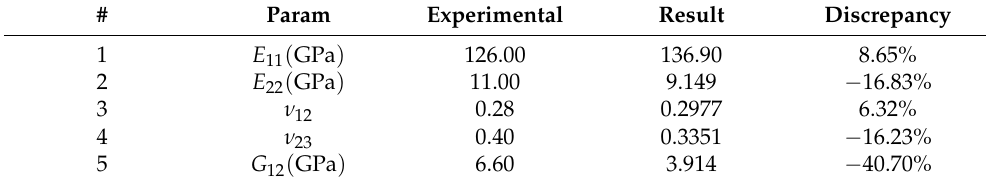
Table 11. Comparisons between the experimental and model updated laminate mechanical properties. # Param Experimental Result Discrepancy 1 E 11 ( GPa ) 126.00 136.90 8.65%